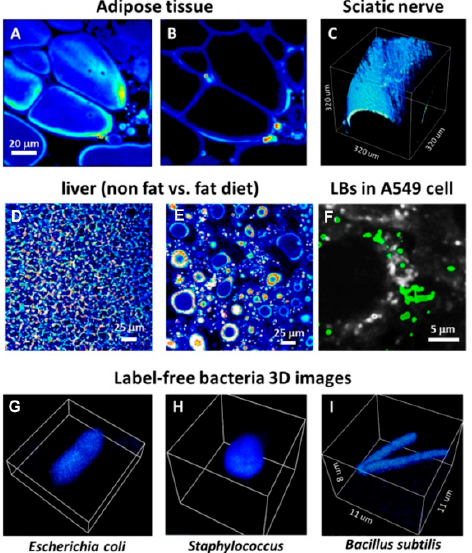
Figure 7. Third Harmonic Generation (THG) images. ( A ) Cell membranes and ( B ) interfaces between cells in adipose tissue. ( C ) 3D image of a mouse sciatic nerve. ( D ) and ( E ) lipids deposition in liver from non-fat or fat diet mouse respectively. ( F ) Overlap of THG signal (green) and NADH autofluorescence from in vivo A549 cells. The green structures refer to lamellar bodies (LBs). ( G – I ) 3D-THG images of various bacteria.